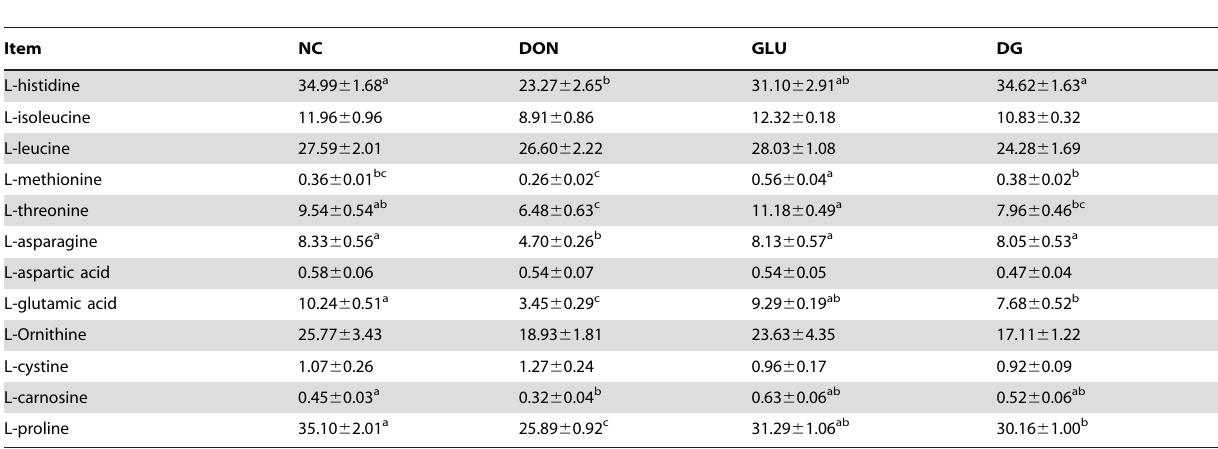
Table 6. Effect of dietary supplementation with glutmic acid on serum amino acids levels in piglets fed deoxynivalenol- contaminated feed on day